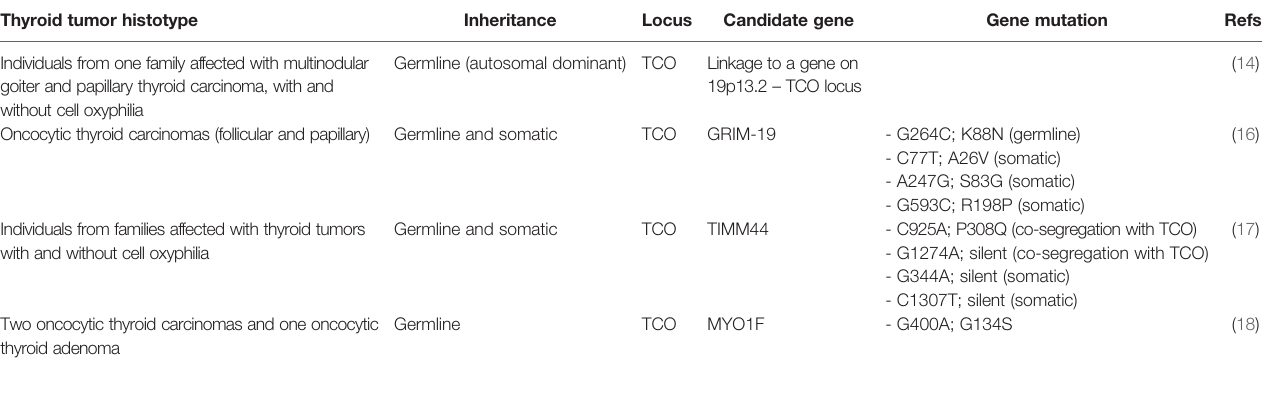
TABLE 1 | Summary of genetic linkage and gene mutations that are associated with hereditary thyroid tumors with oncocytic